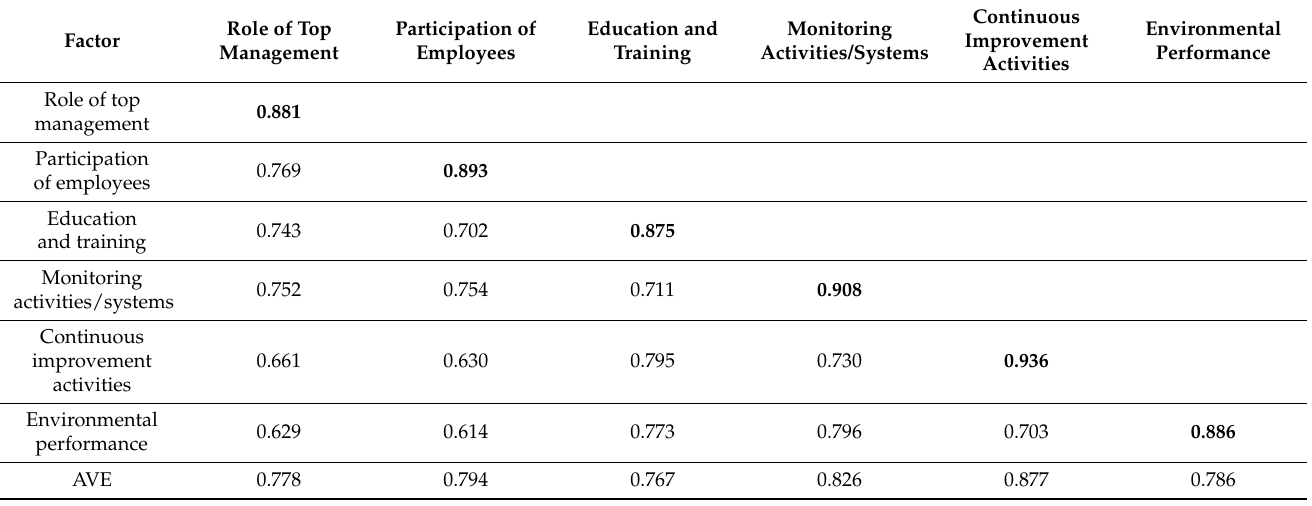
Table 7. Correlation matrix and average variance extracted